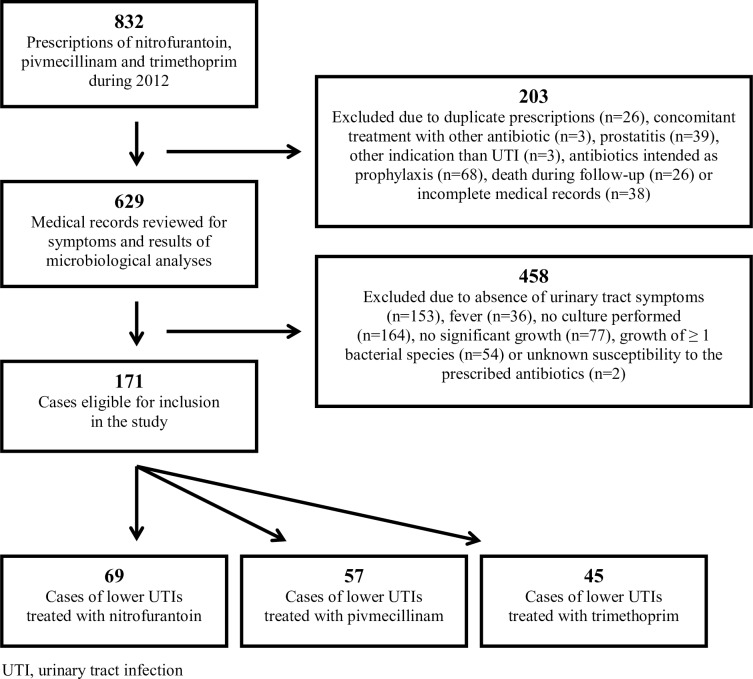
Flow chart of the inclusion process.